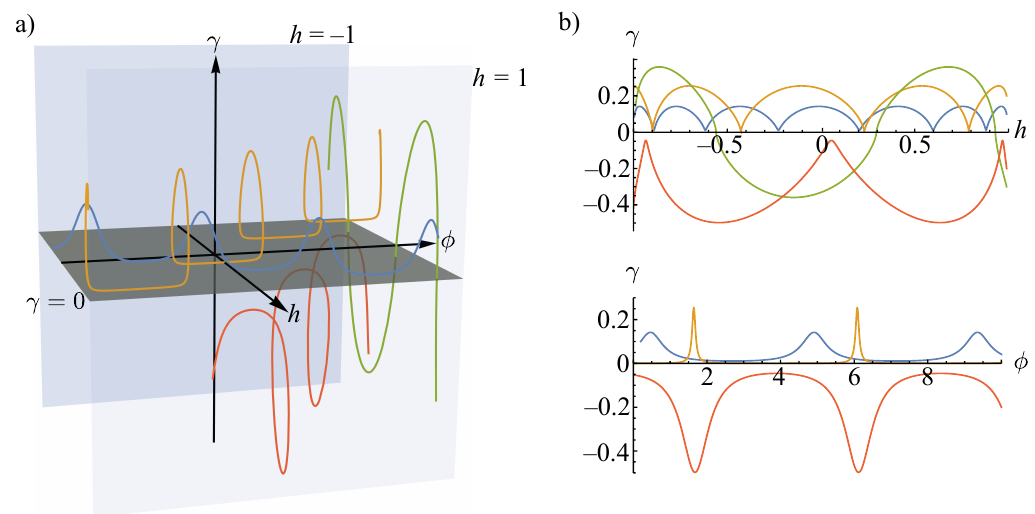
Figure 2: a) Geodesics in the ferromagnetic sector of the ground-state manifold. The = − 0.9, − 0.7, − 0.6, − 0.47 and Q = 0.05, − 0.01,0, − 0.1 different solutions have Q φ u for blue, orange, green and red respectively. b) The projections onto the uv -plane and φ u -plane. Note that only the green curve with Q = 0 and constant φ ( s ) probes the φ two ferromagnetic phases. All solutions eventually touch the h = ± 1